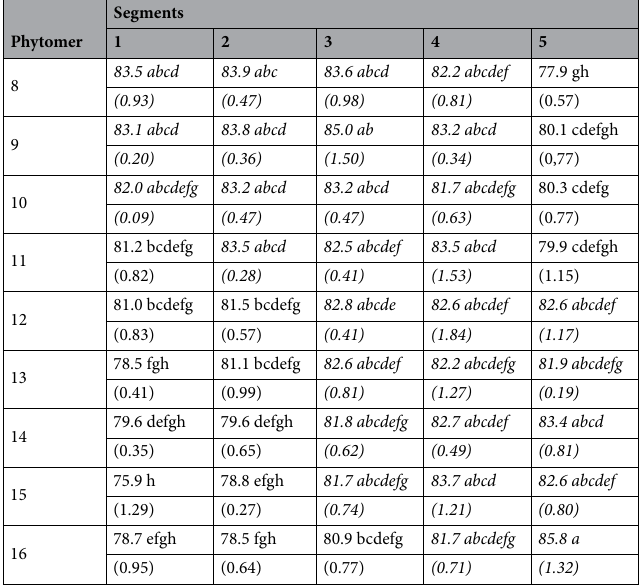
Table 4. In vitro dry matter digestibility (IVDMD) along the blades of Napier elephant grass leaves. Means followed by the same letters are not different ( P > 0.05). Values in parentheses correspond to the standard error of the mean. The highlights in italics indicate similar means.